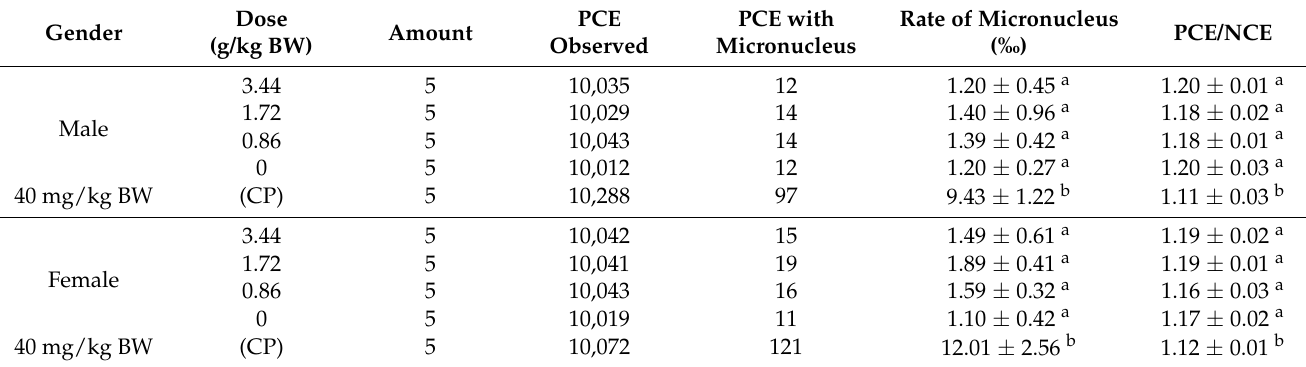
Table 5. The occurrence of micronucleus in mouse PCEs and PCE/NCE value in